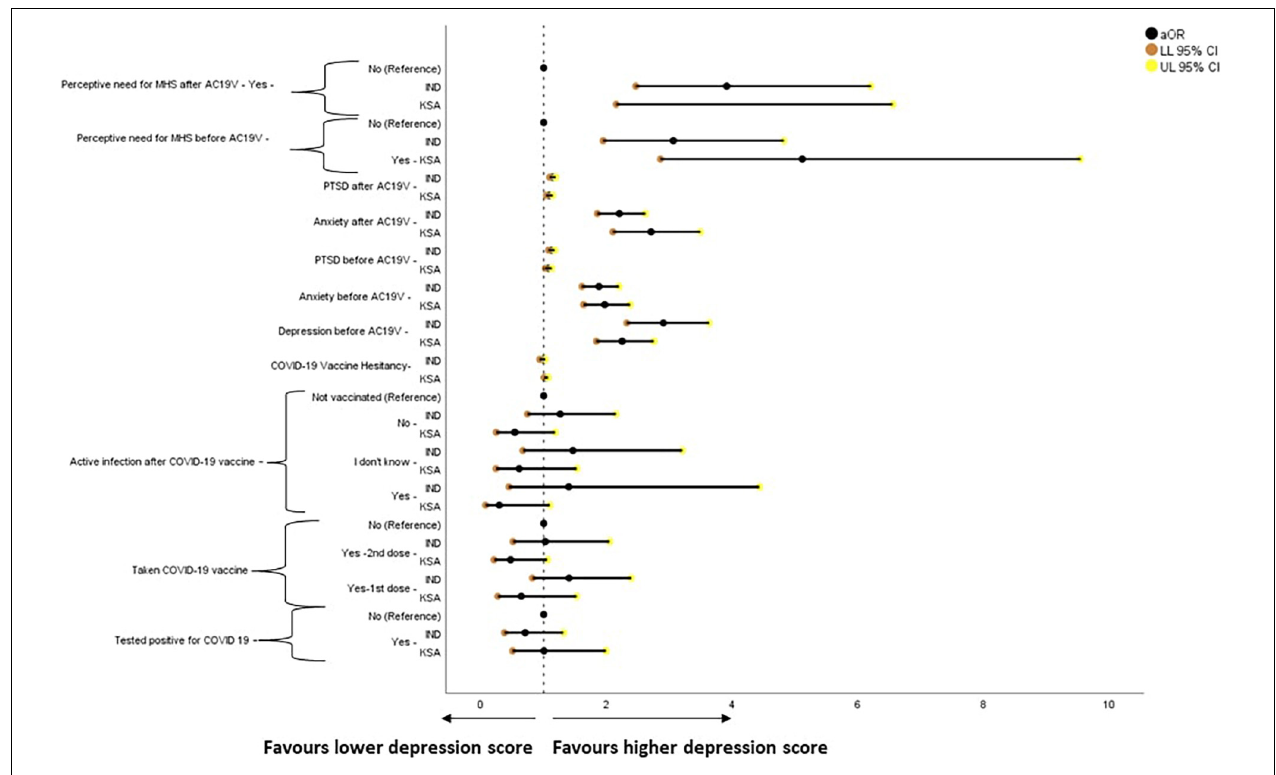
FIGURE 5 | Forest plot showing adjusted binary logistic regression analysis of depression scores (regression model 2). aOR, adjusted Odds Ratio; Odds ratio adjusted for Sociodemographic factors. 95% CI—95% Confidence Interval. The results of regression model 1, 2, and 3 in binary logistic regression analysis of depression scores is tabulated in Supplementary Table 12 . Ind–India; KSA–Kingdom of Saudi